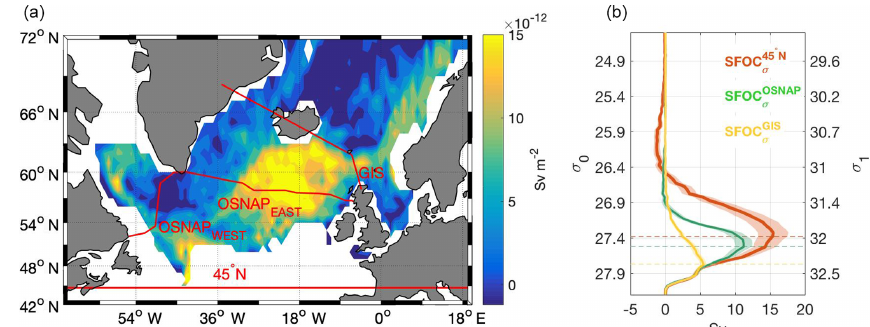
Figure 3. The surface-forced transformation north of 45 ◦ N (SFOC σ ). (a) The 1993–2017 time-mean transformation map across the isopy- cnal surface σ 0 = 27 . 4 (in Svm − 2 ), across which the maximum transformation rate north of 45 ◦ N occurs. (b) The mean SFOC σ stream function (in Sv) at 45 ◦ N (red) at the OSNAP line (green) and at the GIS sills (yellow). See (a) for section locations. Shading indicates the ensemble standard error. The dashed lines depict the density levels of maximum surface-forced transformation rate north for each domain. As the computation was made using σ 0 , the corresponding surface σ 1 values are shown on the right-hand side y axis. The surface integral of the diapycnal volume flux shown in (a) yields the maximum transformation rate through σ 0 = 27 . 4 : 15 . 4 ± 1 .